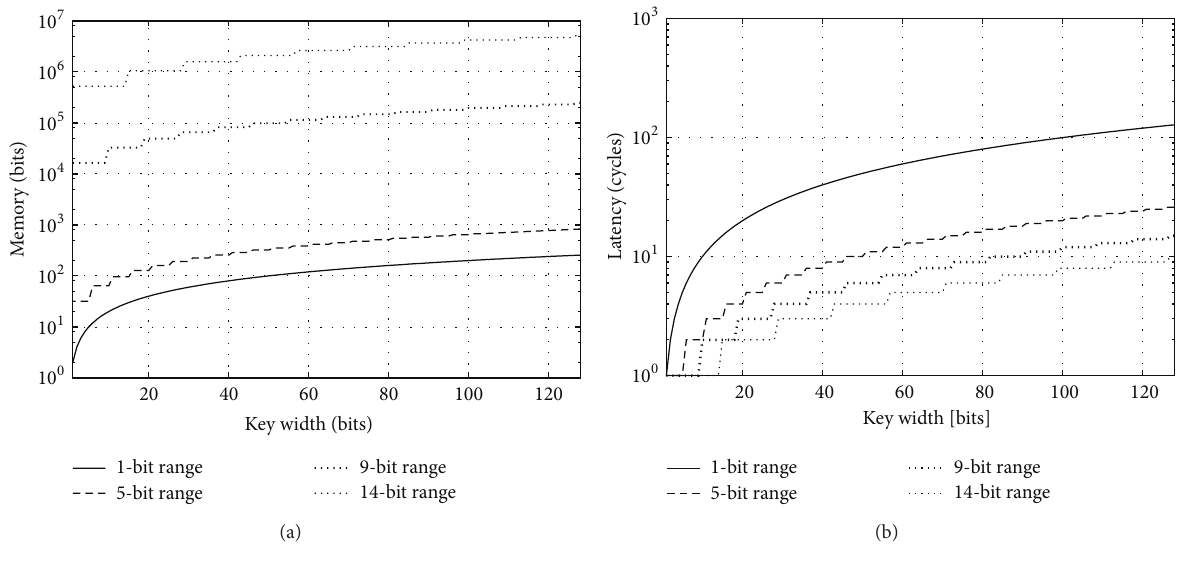
Figure 19: Key width impact: (a) memory footprint and (b)